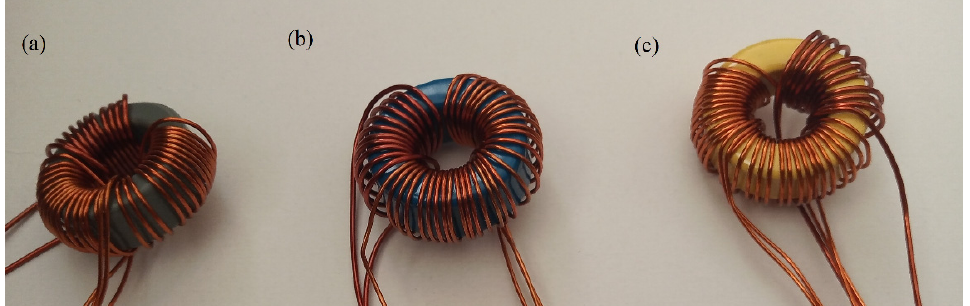
Figure 2. Toroidal transformers with the cores made of ( a ) SM-100, ( b ) RTN, ( c ) RTP. Table 1. Selected material parameters of the used ferromagnetic